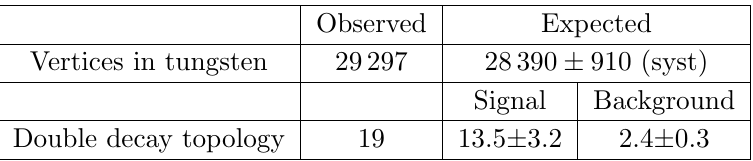
Table 3 . Statistics found in the sub-sample of data in which 5 629 670 protons are analyzed in one unit (1 tungsten plate). The systematic uncertainty on the expected number of vertices is due to the tungsten thickness (cid:13)uctuation of 3.2%.